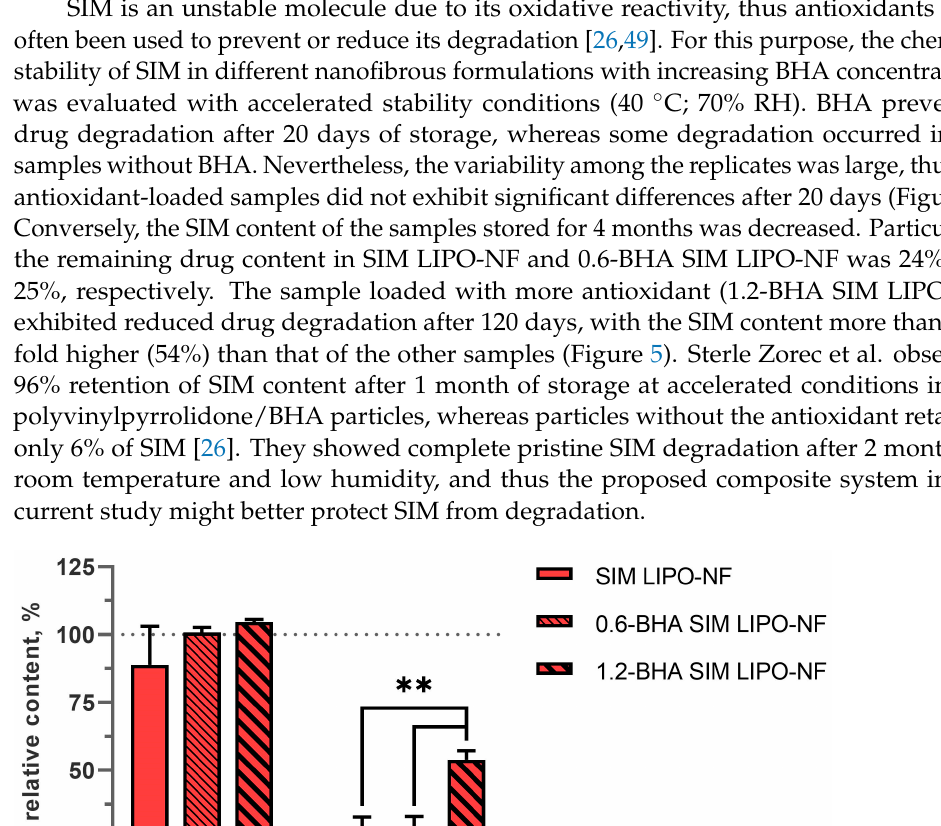
12 of 19 Table 4. Similarity factor ( f 2 ) of the SIM release pro fi les from the three formulations under sink con- ditions. 0-BHA SIM LIPO-NF vs 0.6-BHA SIM LIPO-NF 0-BHA SIM LIPO-NF vs 1.2-BHA SIM LIPO-NF 0.6-BHA SIM LIPO-NF vs 1.2-BHA SIM LIPO-NF